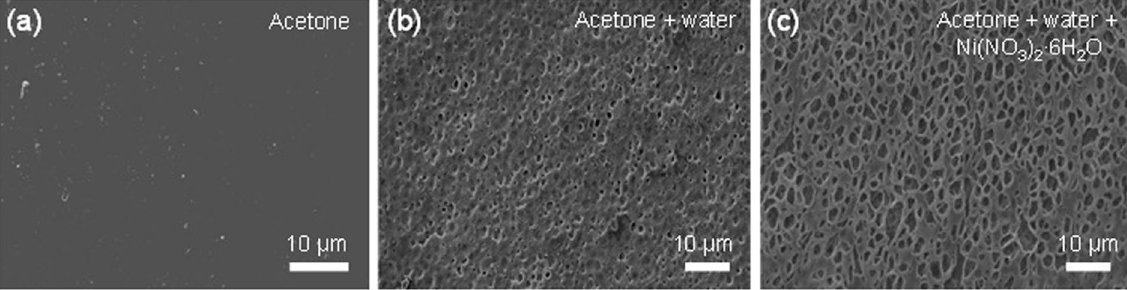
Figure 1. Scanning electron microscopy (SEM) images. ( a ) Pores observed in a neat cellulose acetate (CA) polymer matrix in acetone. ( b ) Neat CA polymer matrix in acetone/water (w/w 8:2). ( c ) 1:0.23 CA/ Ni(NO 3 ) 2 ·6H 2 O polymer matrix in acetone/water (w/w